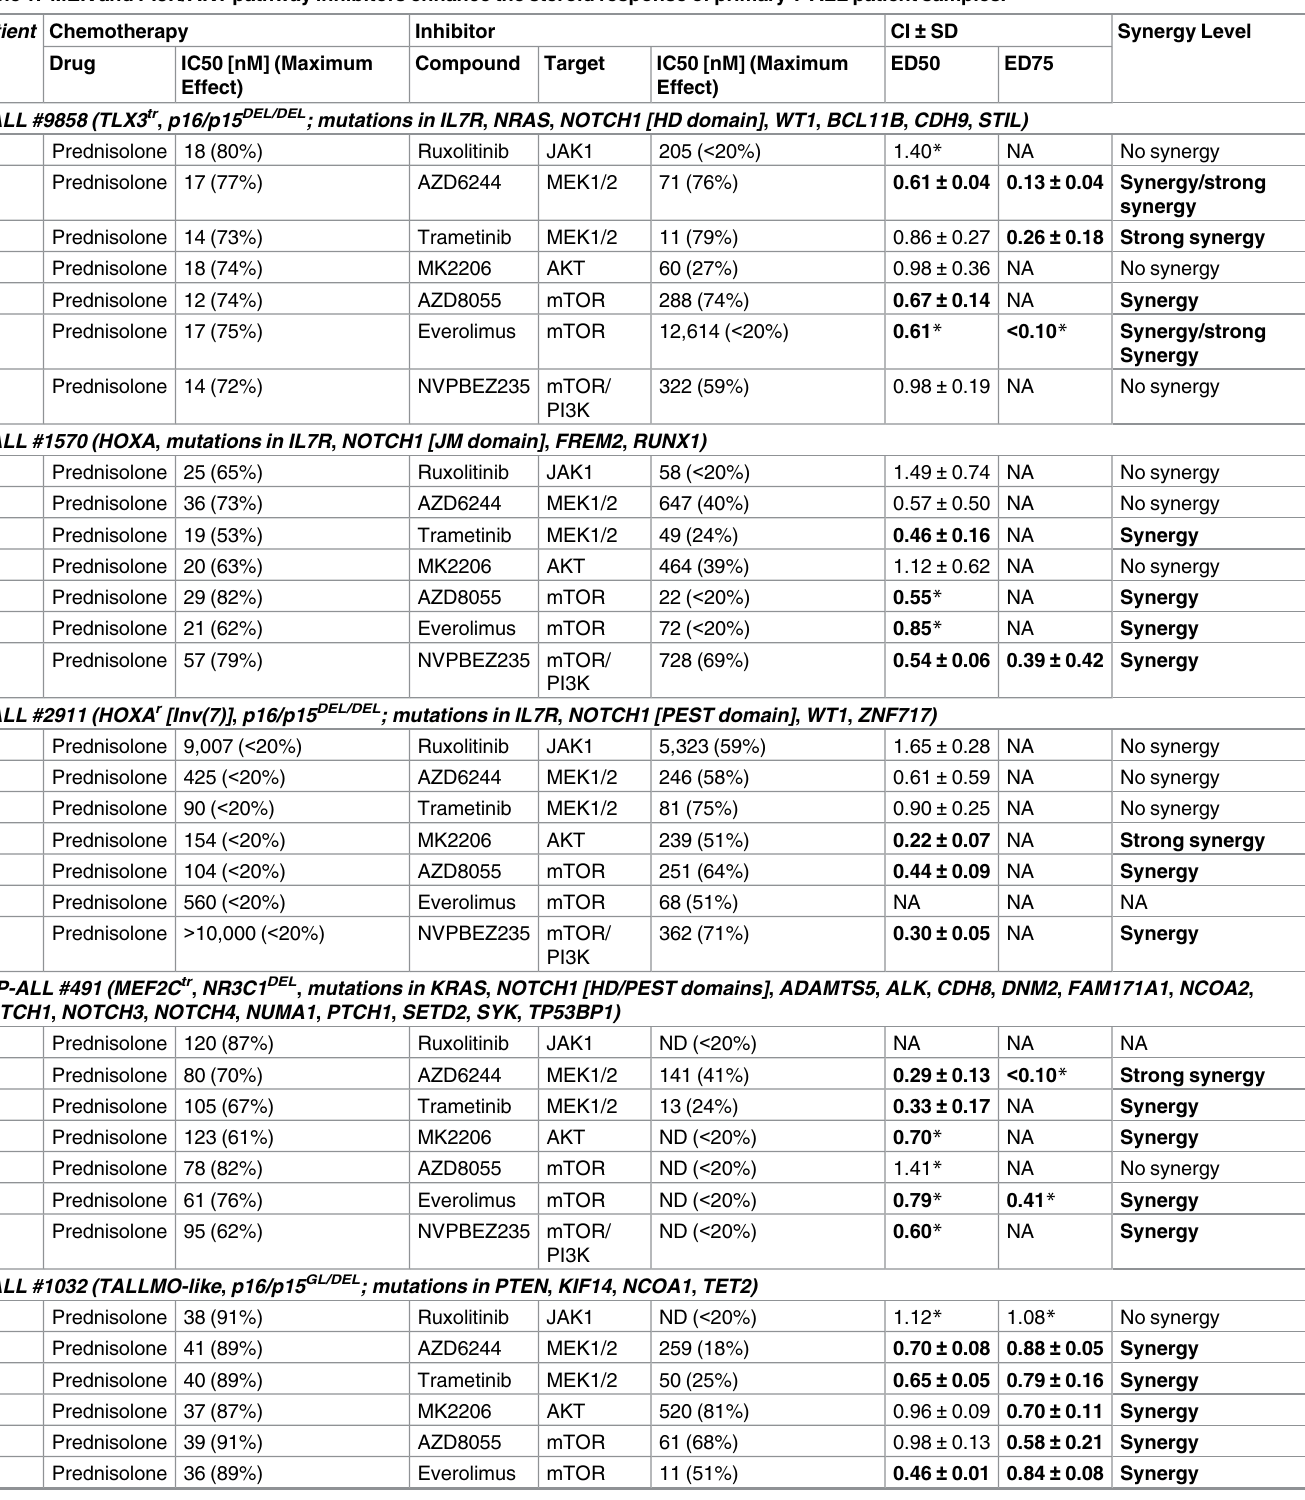
Table 1. MEK and PI3K/AKT pathway inhibitors enhance the steroid response of primary T-ALL patient samples. Patient